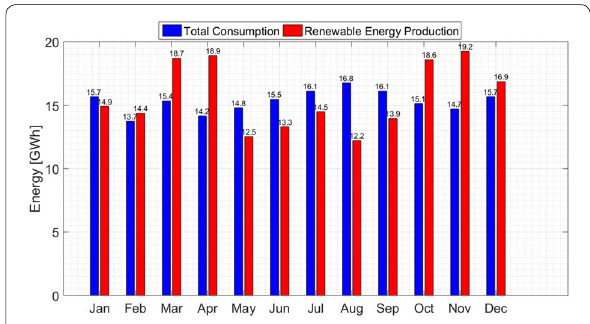
Fig. 10 Estimated total renewable energy emission and monthly consumption for 2018 in Terceira